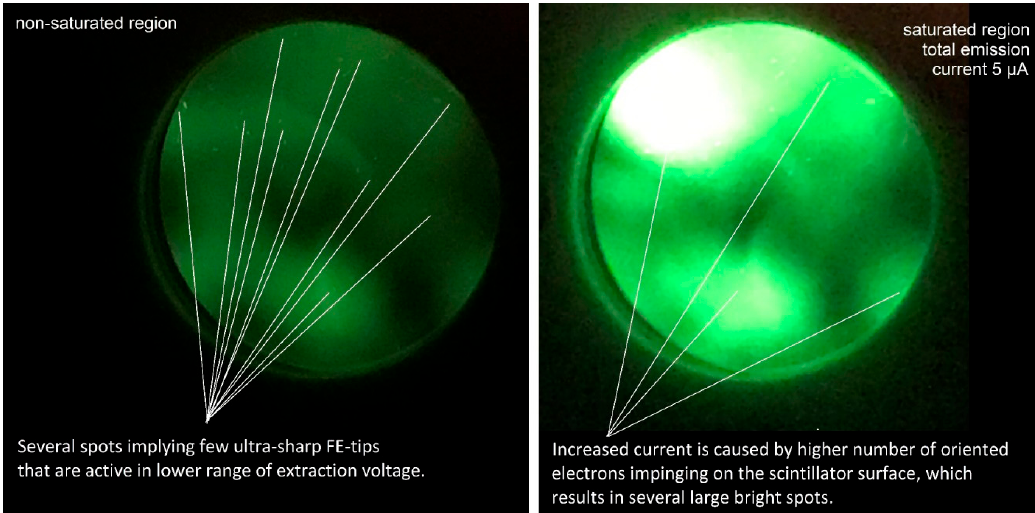
Figure 6. Field Emission Microscope Pattern Images for non-saturated (left) and saturated (right) region of the I-V plot. The diameter of the scintillator plane here is 31.5 mm.